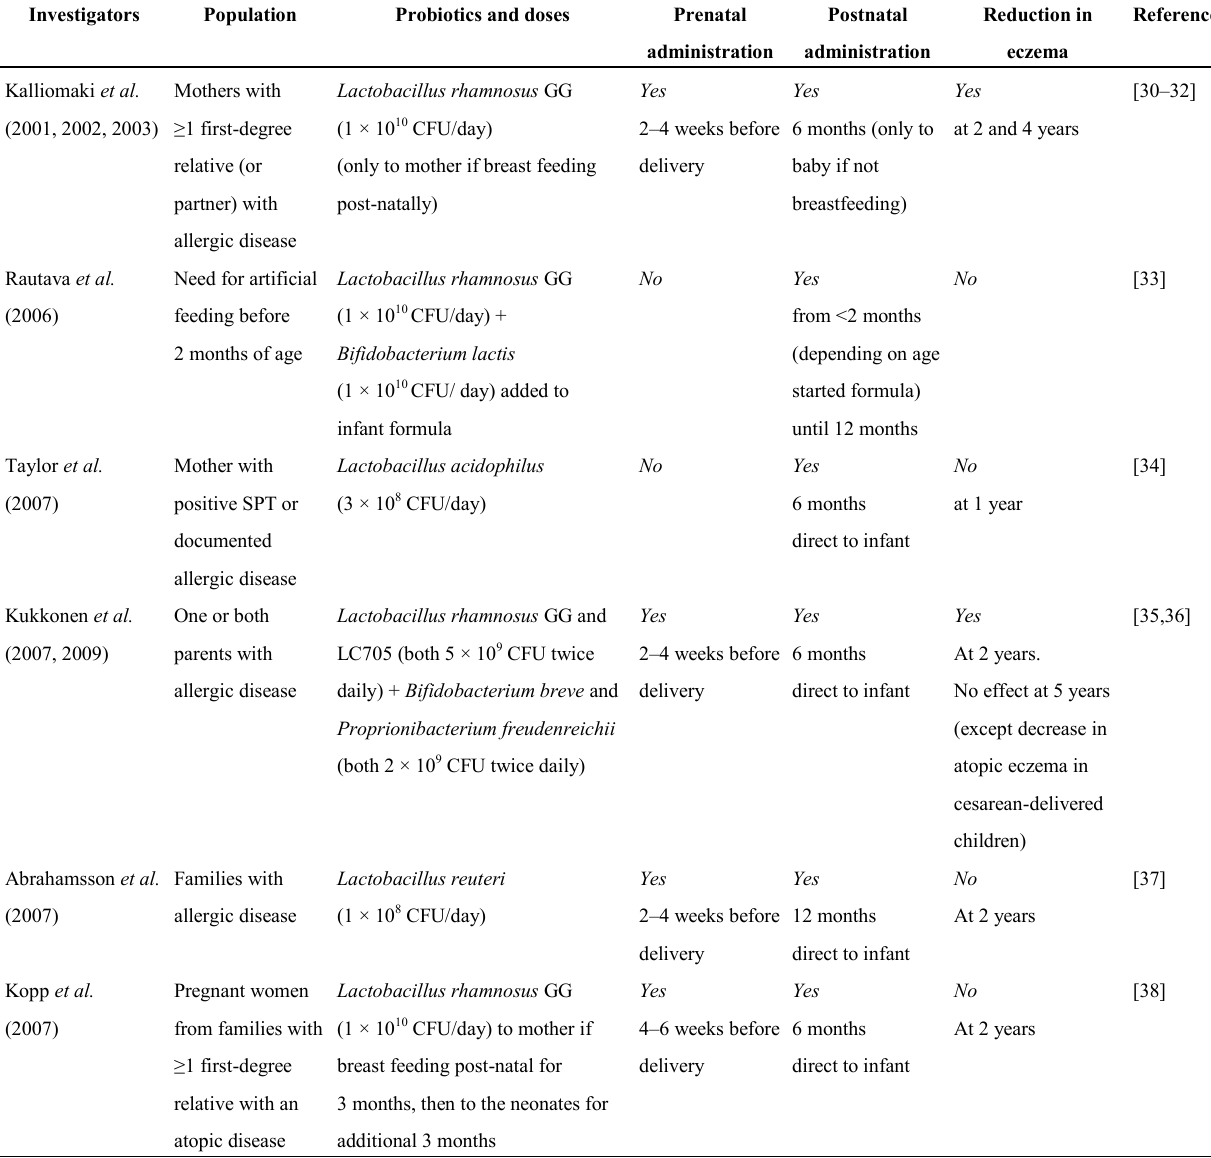
Table 2. Main allergy prevention studies using